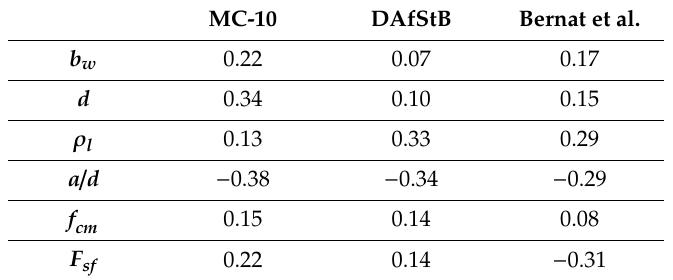
Table 4. Pearson correlation matrix between model and shear parameters.